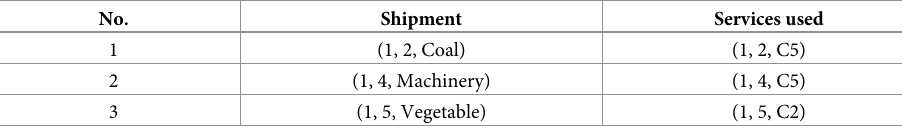
Table 9. Transportation strategy for each shipment.